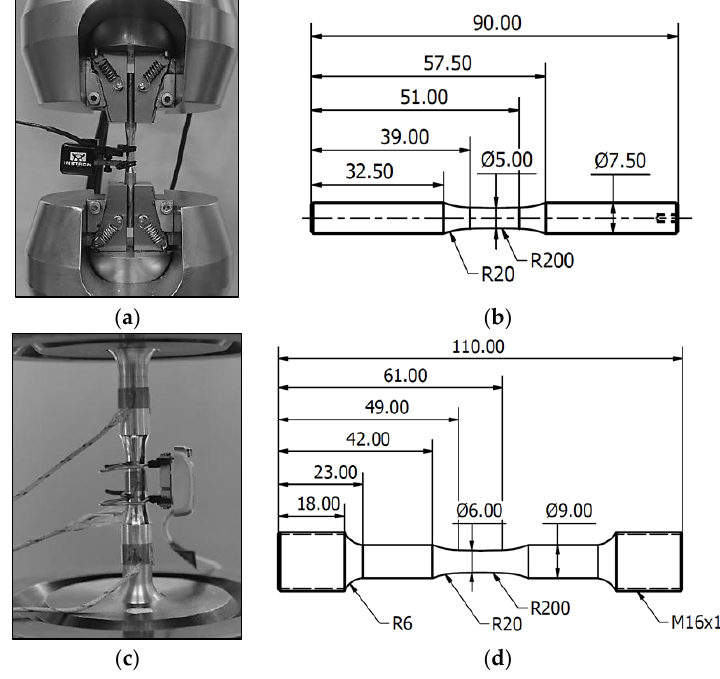
Figure 3. Experimental setup for mechanical testing: ( a ) Servohydraulic testing system; ( b ) Specimen geometry for batches A–D; ( c ) Resonance testing system; ( d ) Specimen geometry for batch D.